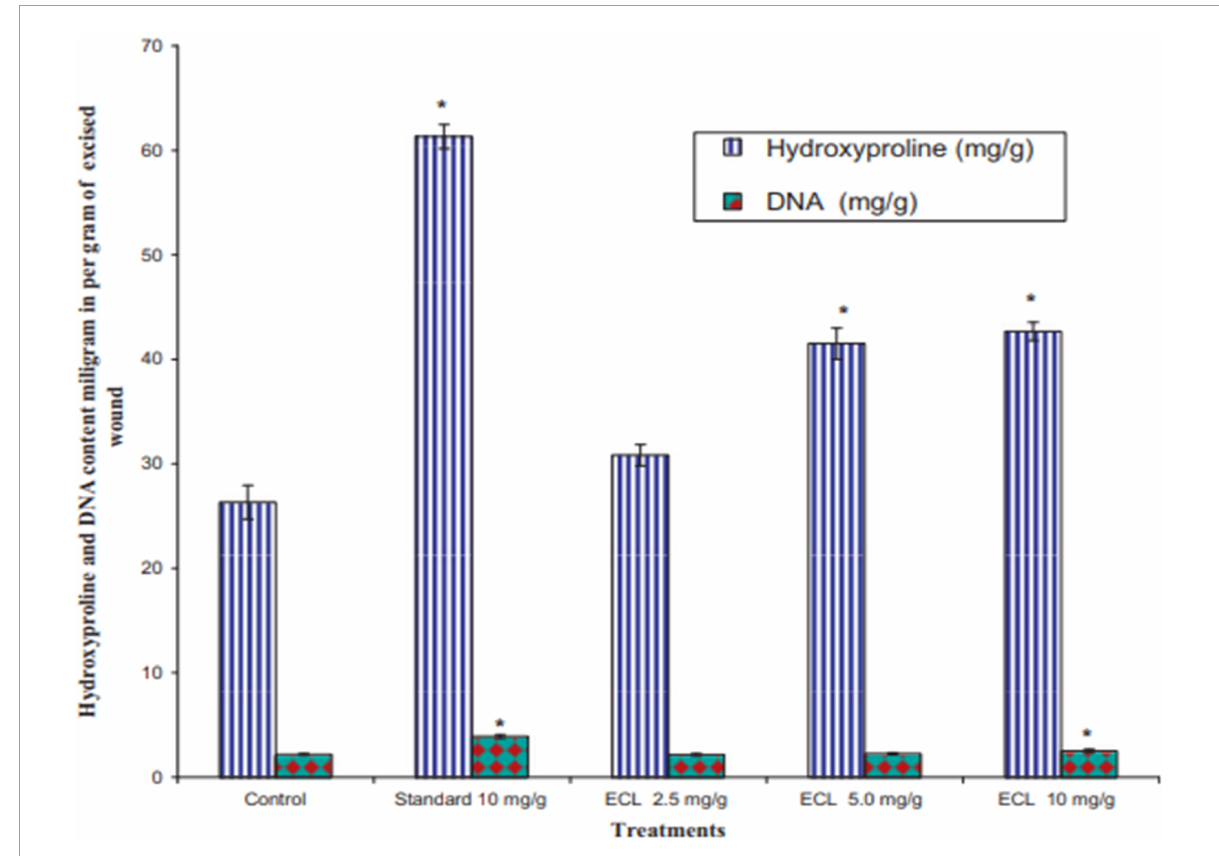
FIGURE19 Effect of latex of E. caducifolia on hydroxyproline and DNA content. Values reported as Mean ± SEM ( n = 6). The data were analyzed by one way ANOVA followed by and Dunnett’s test. * P 0.05 as compared with control group. ECL (latex of E. caducifolia ) (Goyal et al.,